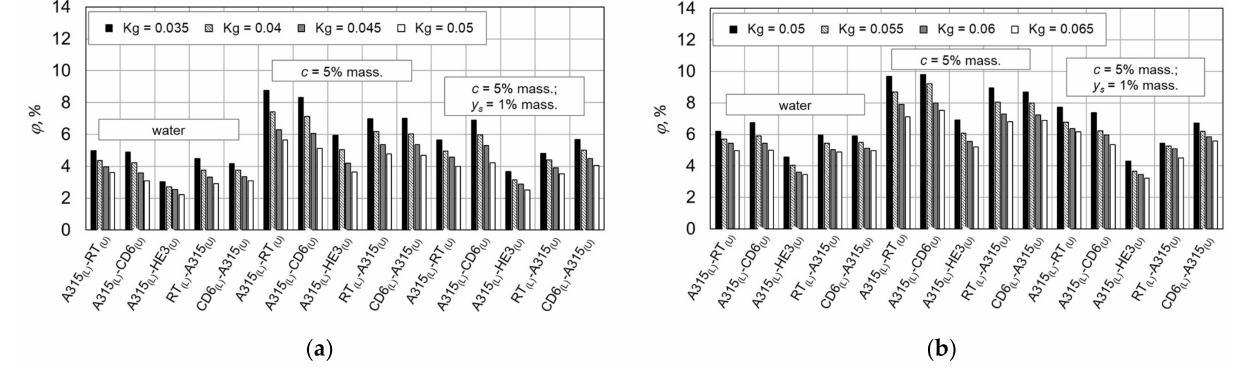
Figure 5. Dependence of ϕ = f(configurations of impeller); standard planer baffles, ( a ) w og = 5.973 × 10 − 3 m/s; ( b ) w og = 8.532 × 10 − 3